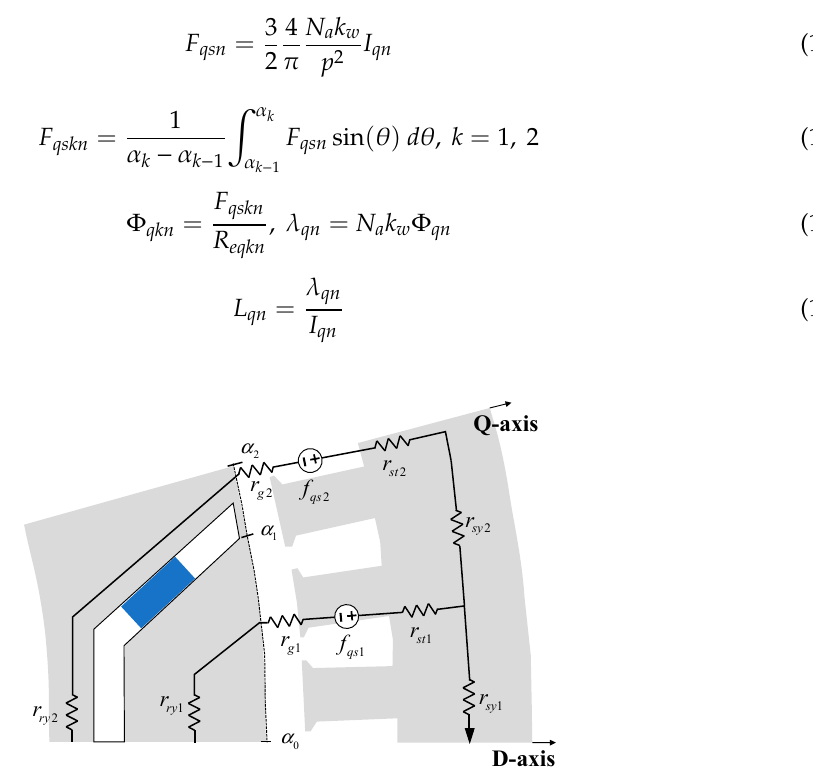
Figure 5. MEC for Q-axis inductance.